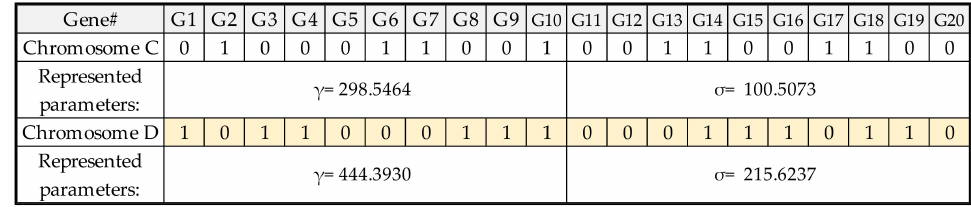
Figure 7. The binary encoding for parameters of LSSVR after multi-point crossover.